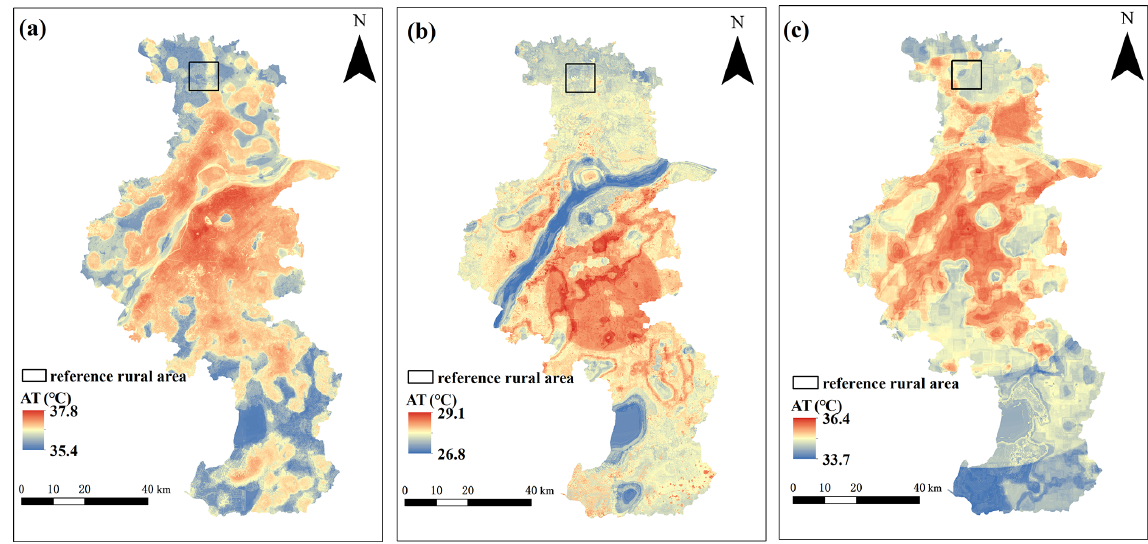
Figure 8. Spatial distribution of AT in Nanjing and the reference rural area: (a) 11 August 2013; (b) 2 September 2015; (c) 21 July 2017.